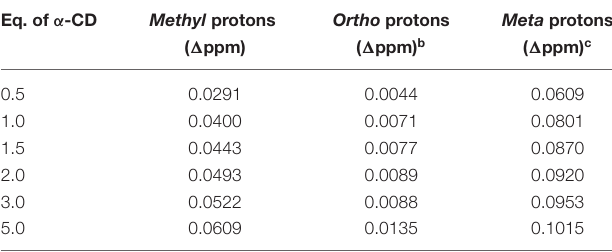
FIGURE 6 | Schematic illustration of how α -cyclodextrin binds to aromatic rings on the pollutant structures to limit aromatic chlorination.